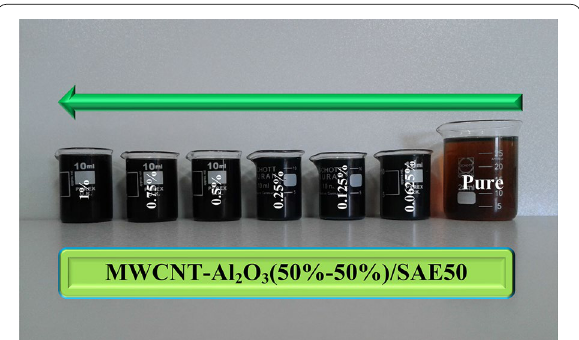
Fig. 4 Stability of non-lubricants at different